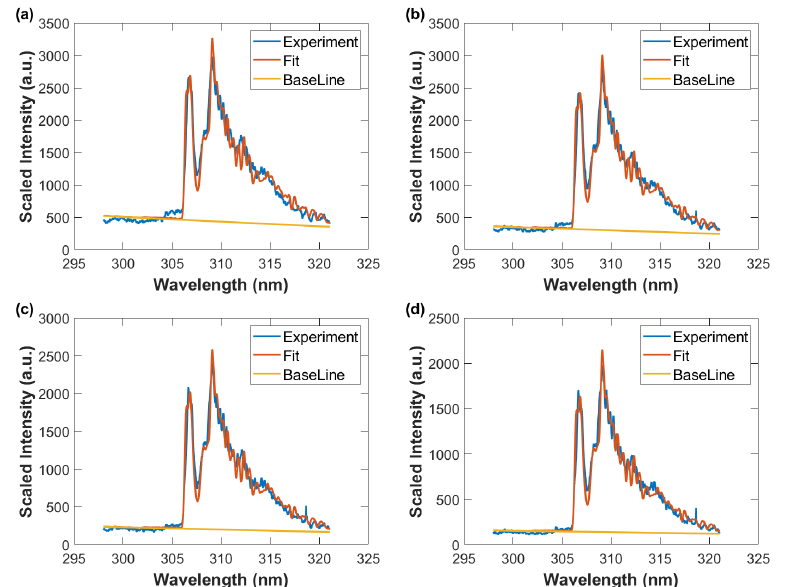
Figure 12. Wavelength-calibrated and sensitivity-corrected spectra average vs. wavelength, fitted data with spectral resolution of 0.35nm, and baseline. Gate width: 10 µ s, time delay ( a ) 50 µ s,